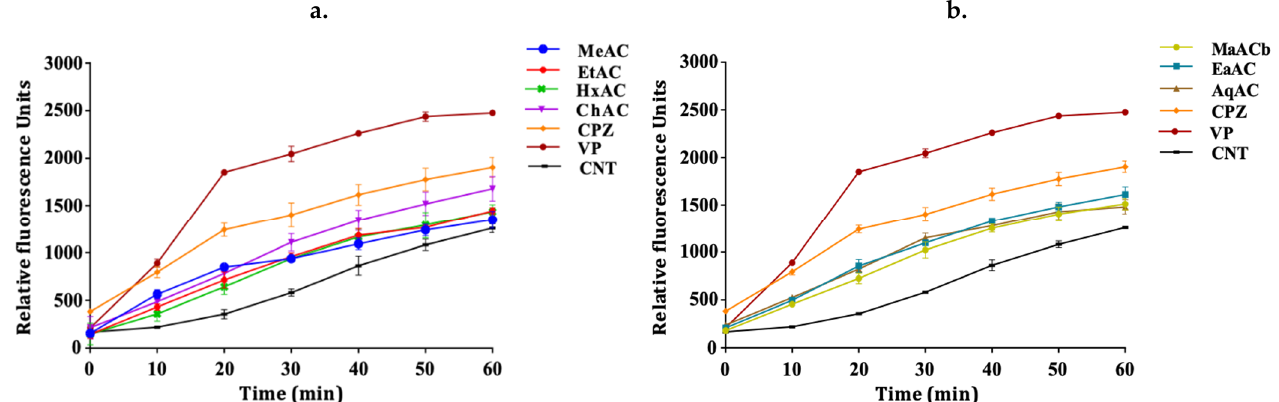
Figure 2. Effect of A. cepa extracts on the accumulation of EtBr in M. smegmatis. ( a ) A. cepa pink: MeAC-methanol, EtAC- ethanol, HxAC-hexane and ChAC-chloroform; ( b ) Allium cepa white: MeACb-methanol, EaAC-ethanol, AqAC-aqueous, CPZ-chlorpromazine; VP-verapamil; CNT-control.